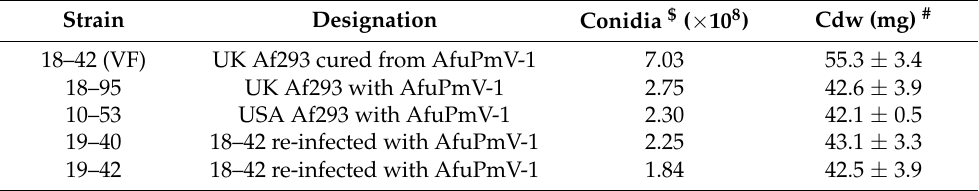
Table 1. The growth characteristics of VF and VI A. fumigatus strains (see text for details). $ Number of conidia harvested from solid medium. # Pellet cell dry weight (cdw) obtained from the liquid medium ( n =